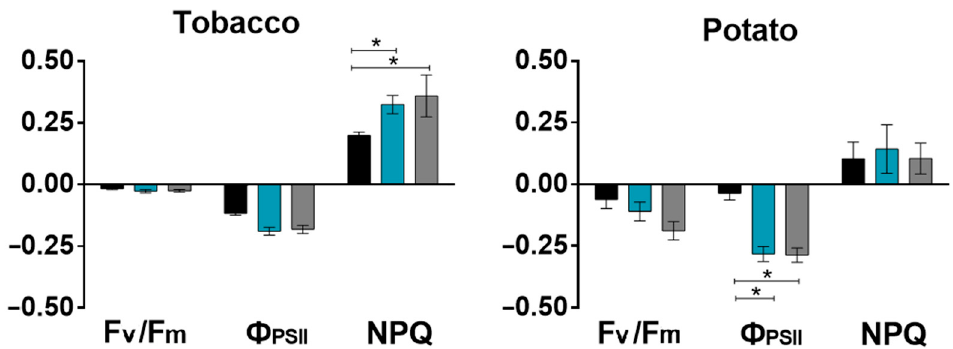
Figure 9. Salt-induced changes of Fv/Fm, φ PSII and NPQ depending on the leaf stratum (1—black, 2—blue, 3—gray) at 56 h after the start of salt treatment. The data are presented as mean ± SEM (n = 9), * p < 0.05 between the two parameters.